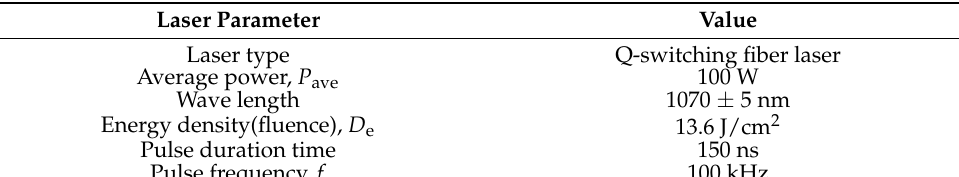
Table 2. The fixed laser parameters for the laser cleaning experiment.